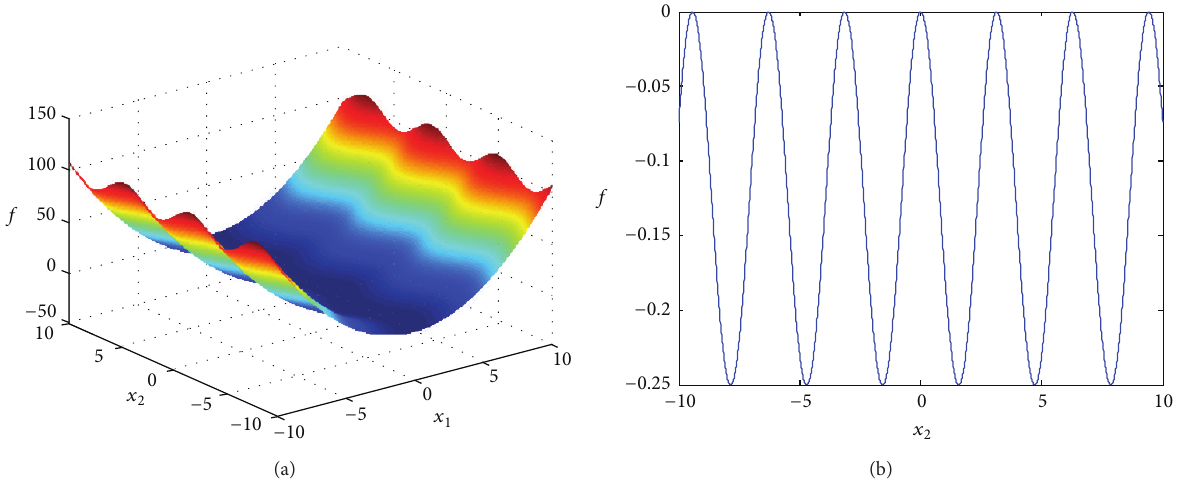
Figure 1: Illustration of an example of variable reduction strategy. (a) Solution space of the original problem; (b) solution space of the problem after variable